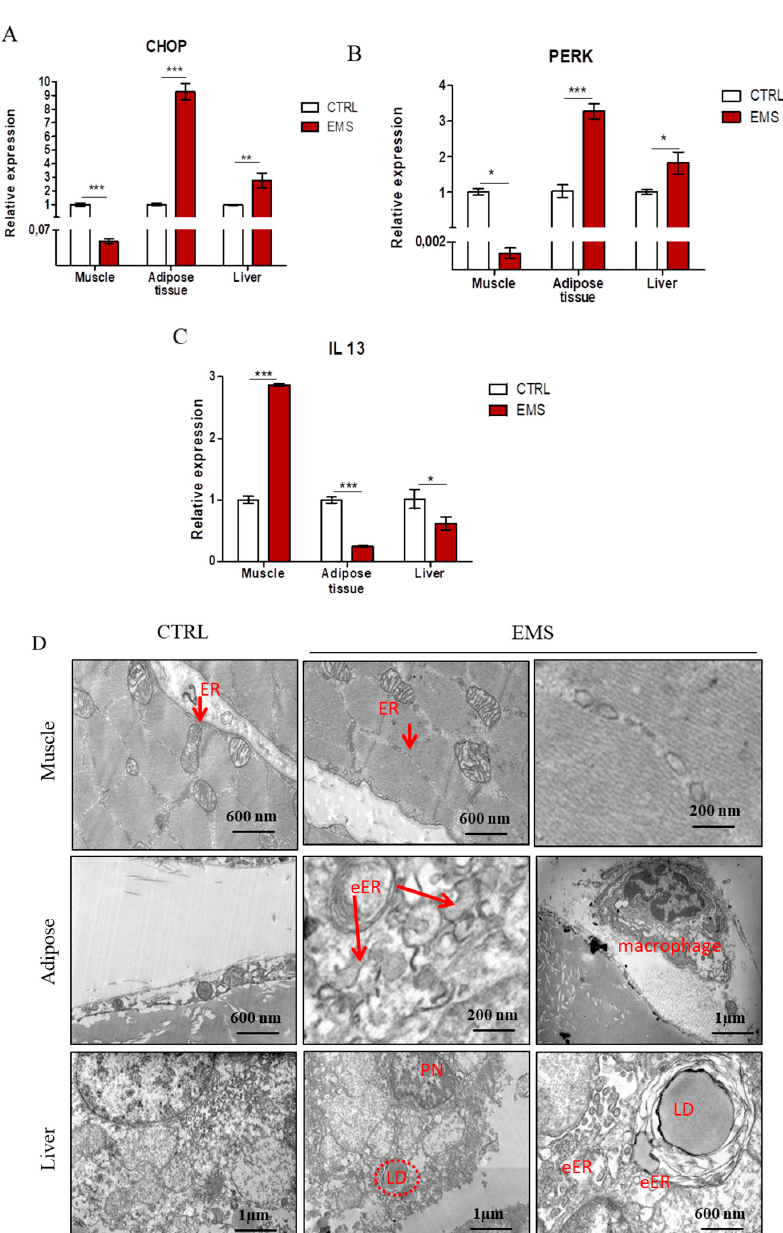
Figure 4. Investigation of ER stress in tissues from healthy and EMS horses. Using RT-PCR, the expression of CHOP ( A ), PERK ( B ) and IL-13 ( C ) was examined. Furthermore, TEM images allowed for visualization of cellular ultrastructure and detection of organelles’ impairment ( D ). Abbreviations: ER, endoplasmic reticulum; eER, enlarged endoplasmic reticulum; LD, lipid droplets; PN, pyknotic nucleus. Results expressed as the mean ± S.D. * p < 0.05, ** p < 0.01, *** p < 0.001.